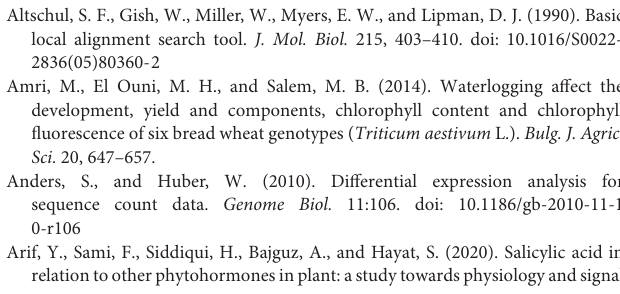
Supplementary Figure 1 | (A) The detailed design of waterlogging experiment. (B) The primary root part displayed in red frame was isolated from the whole root for the following experiments. Supplementary Figure 2 | Quality control of different samples from different biological replicates in the pathway of plant hormone signal transduction. (A) The box-whisker plot of each sample in the pathway of plant hormone signal transduction of S. tonkinensis seedlings under waterlogging stress. The box-whisker plot for each region has five statistics (maximum, third quartile, median, first quartile, and minimum). (B) Principal component analysis (PCA) of root samples of S. tonkinensis seedlings collected at 0, 9, 24, and 72 h. Supplementary Figure 3 | Hierarchical cluster analysis (HCA) of unigenes comparison between 9 and 0 h in the pathway of plant hormone signal transduction of S. tonkinensis seedlings under waterlogging stress. Red blocks represent high expression of unigenes, and blue blocks represent a low expression of unigenes. These unigenes in the figure above need to meet the threshold that p < 0.05 and | log2FC| > 1. Supplementary Figure 4 | Hierarchical cluster analysis of unigenes comparison between 24 and 0 h in the pathway of plant hormone signal transduction of S. tonkinensis seedlings under waterlogging stress. Red blocks represent a high expression of unigenes, and blue blocks represent a low expression of unigenes. These unigenes in the figure above need to meet the threshold that p < 0.05 and | log2FC| > 1. Supplementary Figure 5 | Hierarchical cluster analysis of unigenes comparison between 72 and 0 h in the pathway of plant hormone signal transduction of S. tonkinensis seedlings under waterlogging stress. Red blocks represent a high expression of unigenes, and blue blocks represent a low expression of unigenes. These unigenes in the figure above need to meet the threshold that p < 0.05 and | log2FC| > 1. Supplementary Figure 6 | The up- or downregulation of DEGs in plant hormone signal transduction pathway sorted by gene functions. Supplementary Figure 7 | The relative expression from qRT-PCR of IAA (A) , PYL (B) , EBF1_2 (C) , EIN3 (D) , MYC2 (E) , NPR1 (F) , AHP (G) , and AUX1/LAX (H) in roots of S. tonkinensis seedlings under waterlogging stress after 0, 9, 24, and 72 h, respectively. Different lowercase letters within each graph indicate significant differences ( p < 0.05) among the samplings, whereas different capital letters within each graph indicate significant differences ( p < 0.01) among the